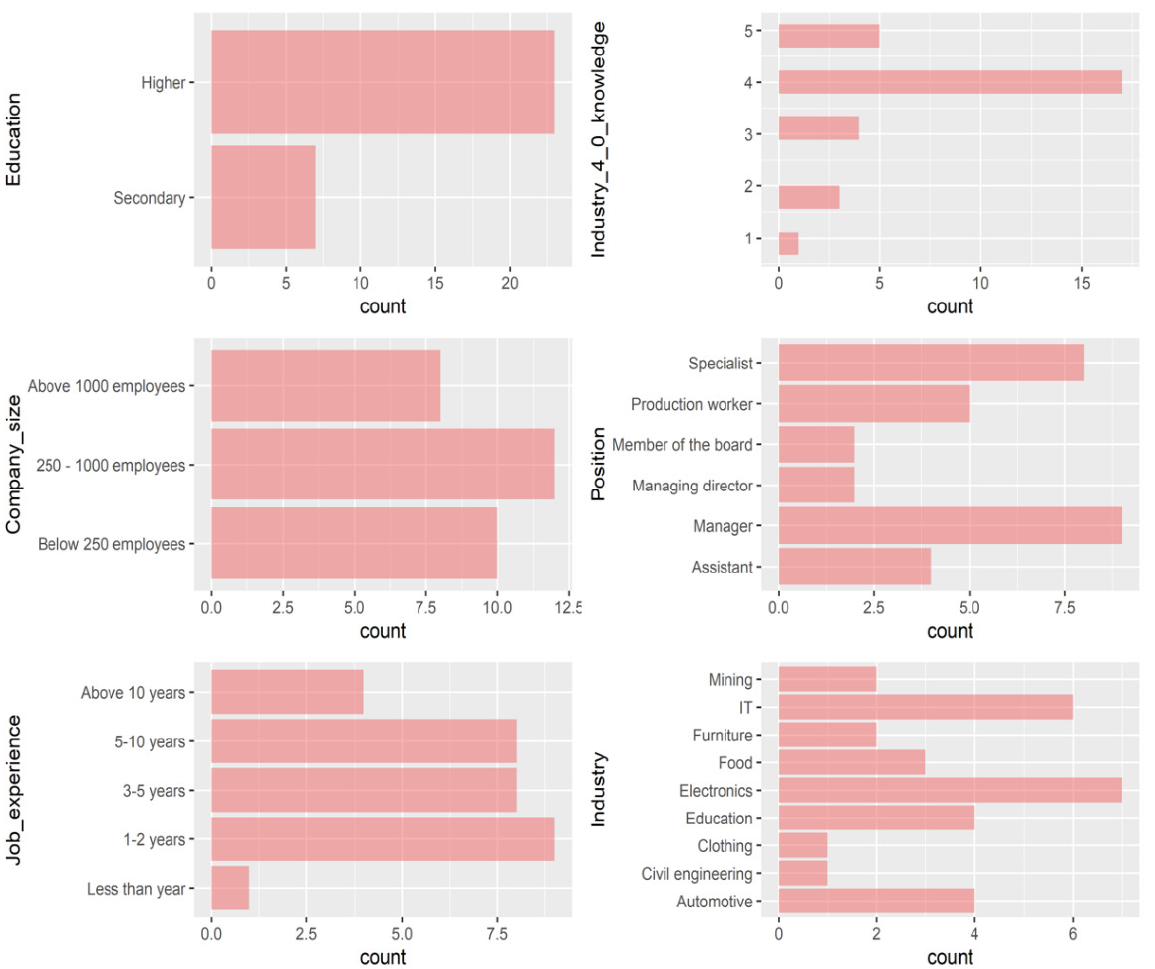
Figure 1. Characteristics of employees in the trial. Source: own elaboration.